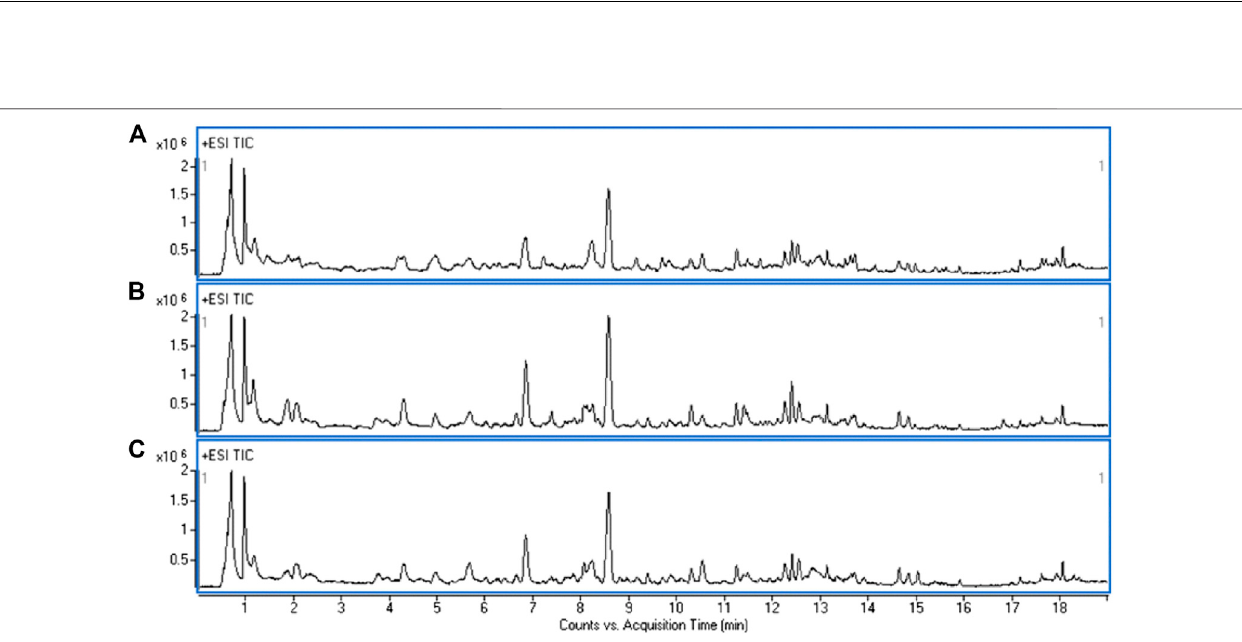
Frontiers in Pharmacology |